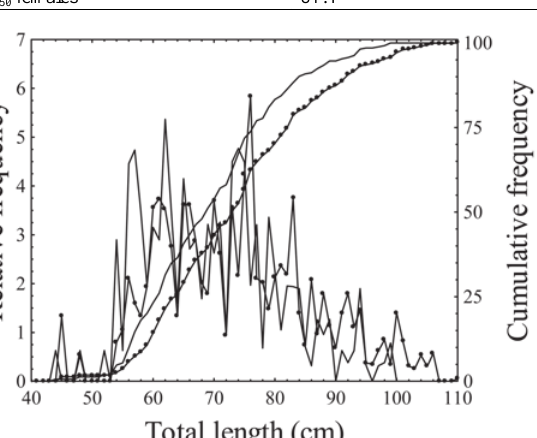
Fig. 3. Relationship between total length (cm) and clasper length (cm) for Dipturus chilensis (immature=filled circles; mature= open circles).